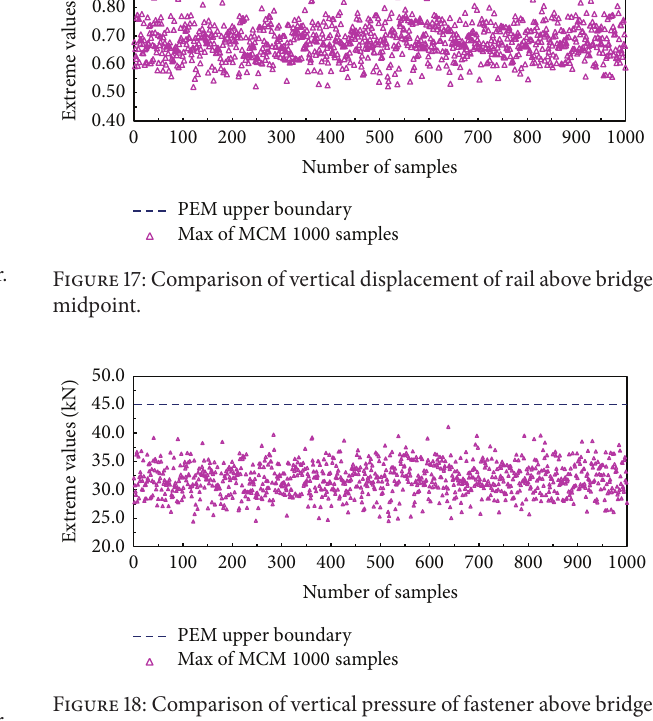
Figure 14: Comparison of wheel load decrement ratio of trailer car.